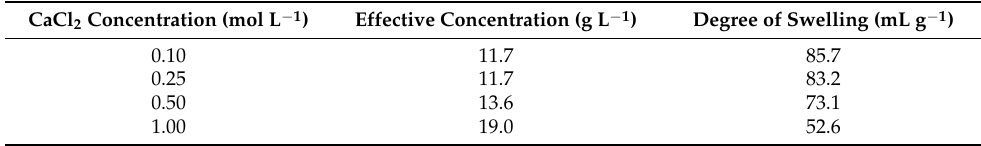
Figure 14. Effect of calcium ion concentration on the viscoelastic behavior of G′ and G″ as a function of the frequency sweep. APP-E at 10 g L −1 dialyzed against different concentrations of CaCl 2 at 25 °C for an applied oscillatory strain γ = 0.1%. Table 6. Effective polymer concentration and degree of swelling of gel formed from a 10 g L − 1 solution of APP-E. Role of CaCl 2